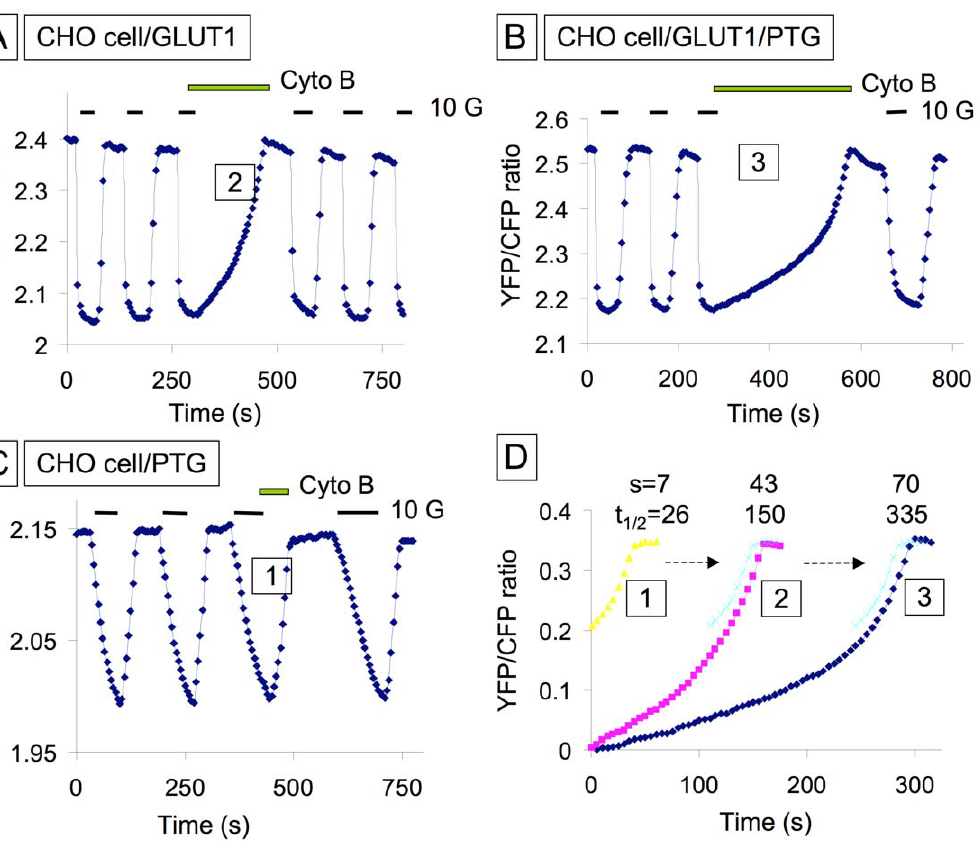
Figure 5. Overexpression of PTG delays glucose clearance. Panels A and B obtained with CHO cells overexpressing GLUT1 illustrate how exogenous PTG delays glucose clearance. In both cases the cells were exposed to extracellular glucose for 50 s. Comparison of data in Panel B (overexpressed GLUT1) and C (no GLUT1 overexpression) illustrate the lack of effect of exogenous PTG in the absence of GLUT1 overexpression, supporting the hypothesis that GLUT1 is necessary for rapid build up of the glycogen store and inhibition of glucose utilization. Compilation of traces in D illustrates once more that the final rate of glucose clearance is similar in all cases and that increased glycogen synthesis only delays glucose